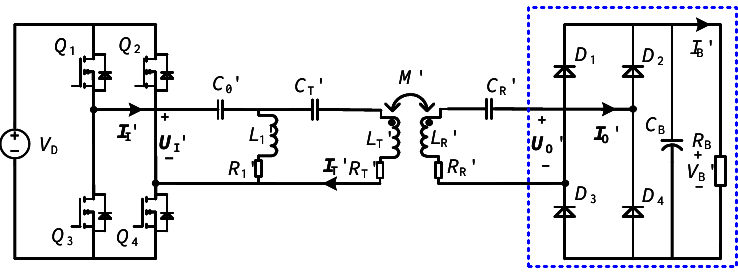
Figure 7. Architecture diagram of the CLC/S compensated WPT system.